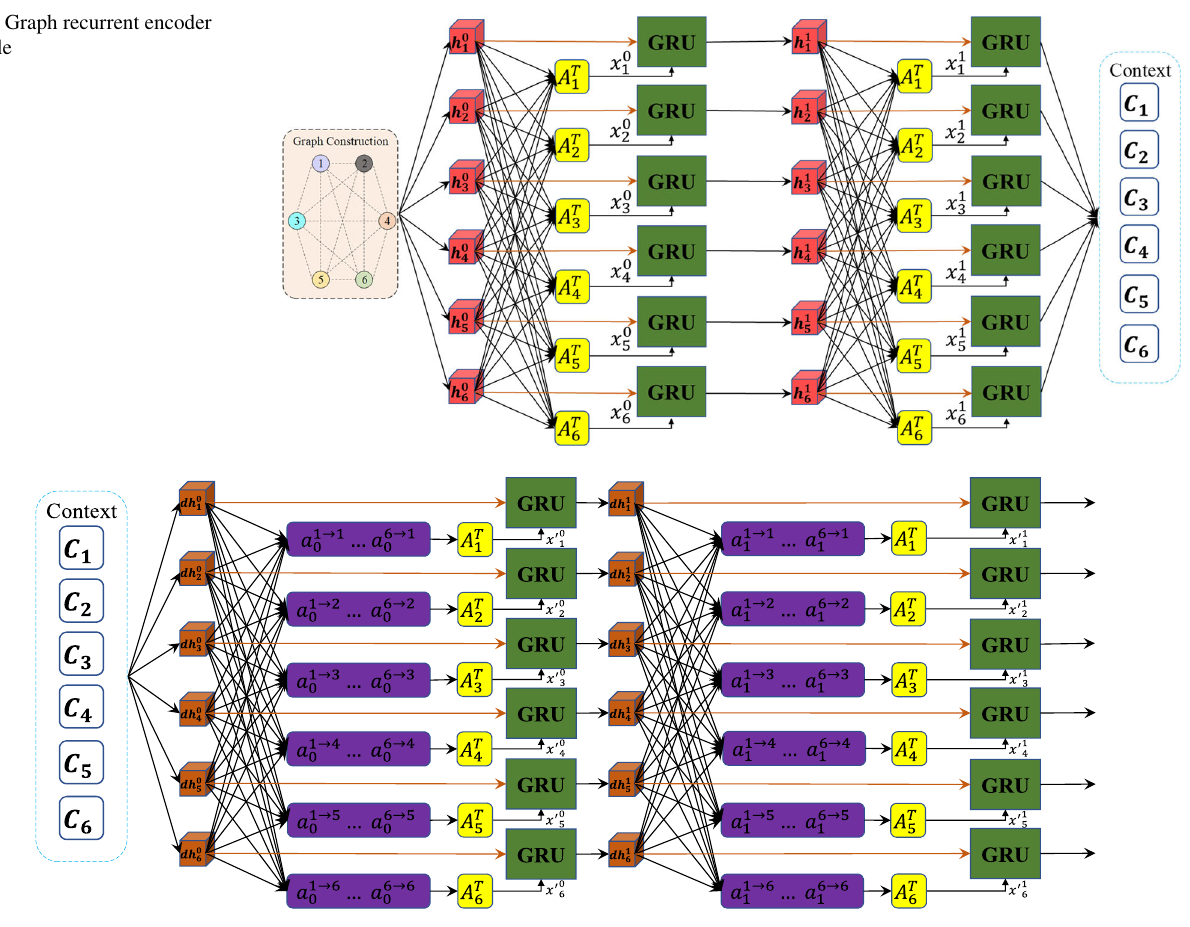
Fig. 7 Graph recurrent attention decoder